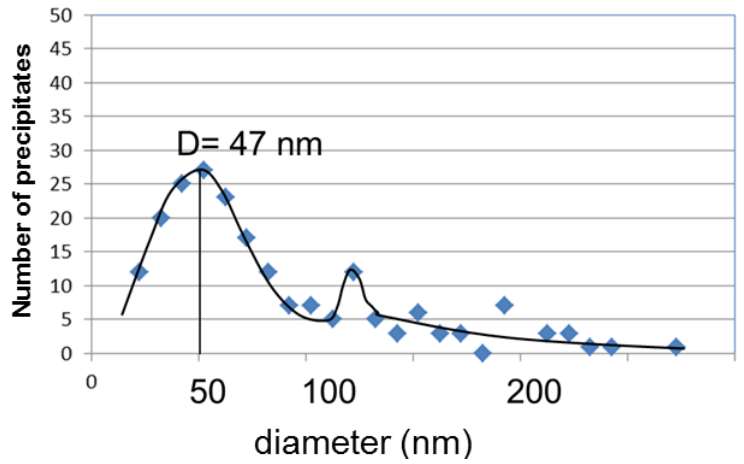
Figure 4. Precipitate size distribution in the peak-aged condition.